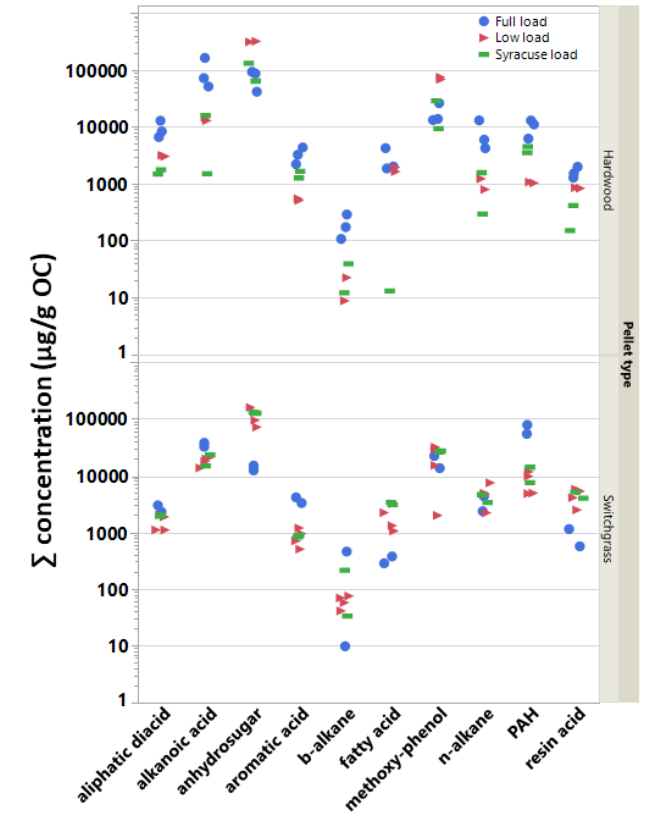
Figure 3. Concentration sums ( µ g/gOC) for individual tests sorted by compound class, test load conditions, and fuel type (HW: hardwood pellet; SwG: switchgrass